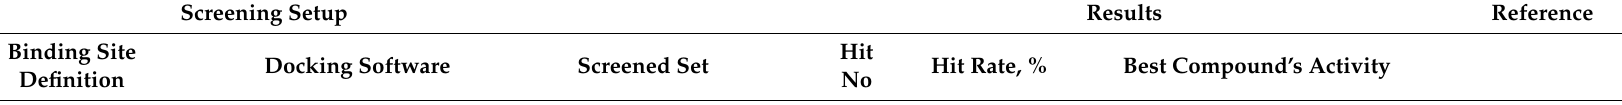
Table A5. Protein-Ligand